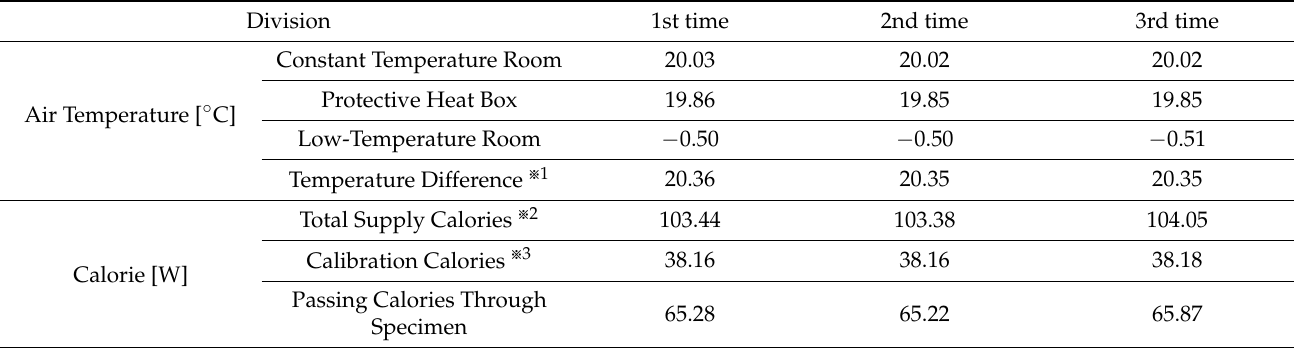
Table 13. Heat transmittance test